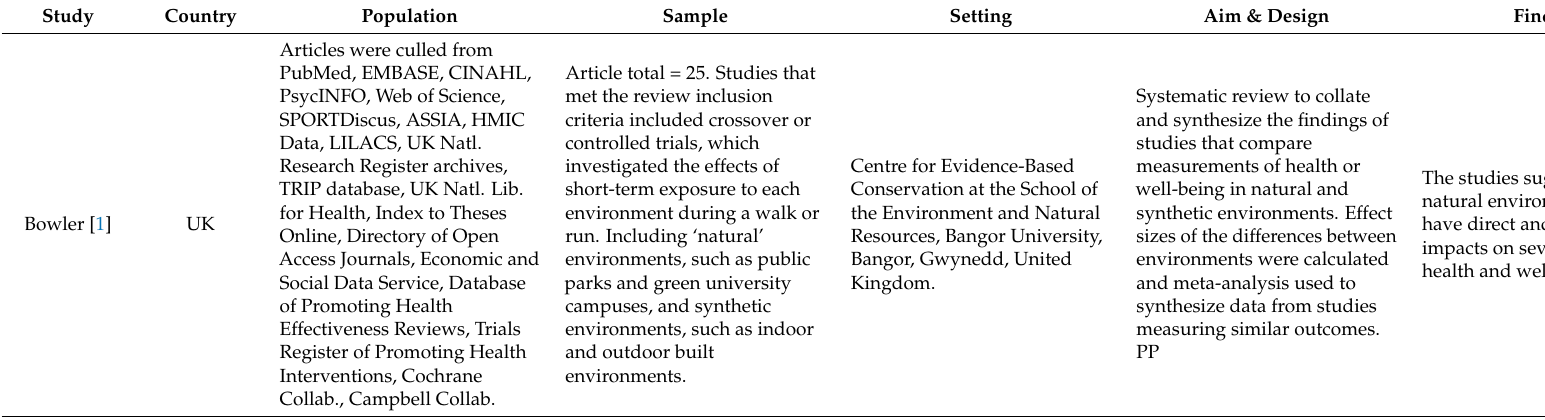
Table 1. Characteristics of selected studies and supporting